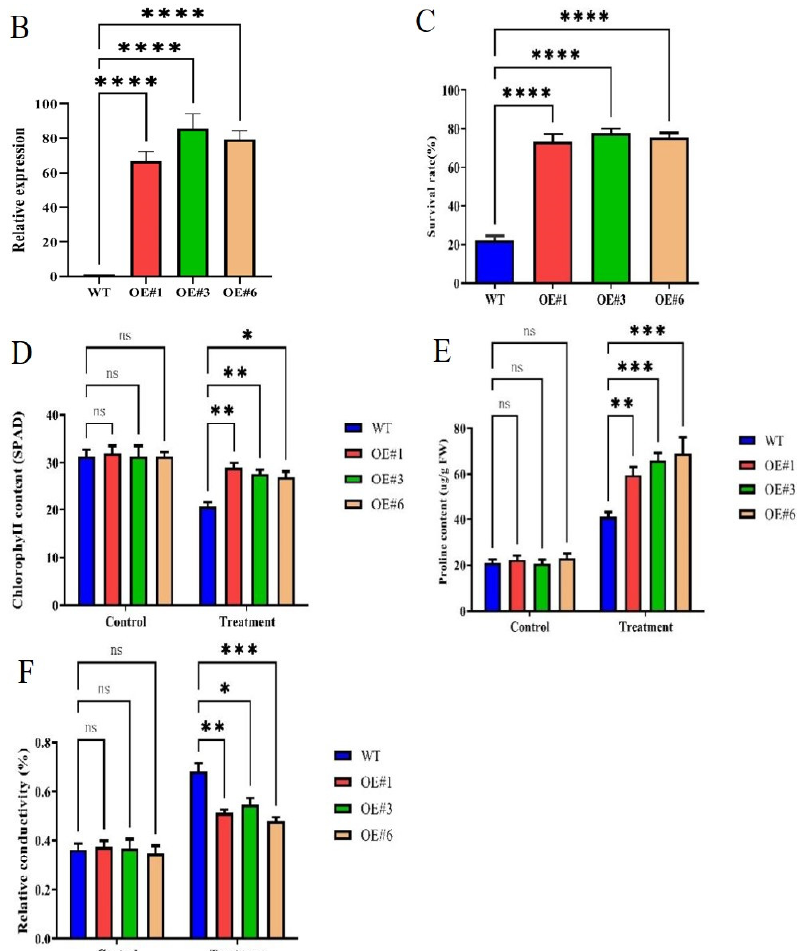
Figure 1. Phenotype ( A ), relative expression (B), survival rate ( C ), chlorophyll content ( D ), proline content ( E ), and relative conductivity ( F ) of control (0 mM NaCl) and salt ‐ treated (200 mM NaCl) soybean seedling leaves after 36 h. Note: A group–group significance analysis was performed, and each treatment (OE#1, OE#3, and OE#6) was compared to WT. All values are presented as the mean ± SD of three independent experiments. * p < 0.05, ** p < 0.01, *** p < 0.001, **** p < 0.0001.